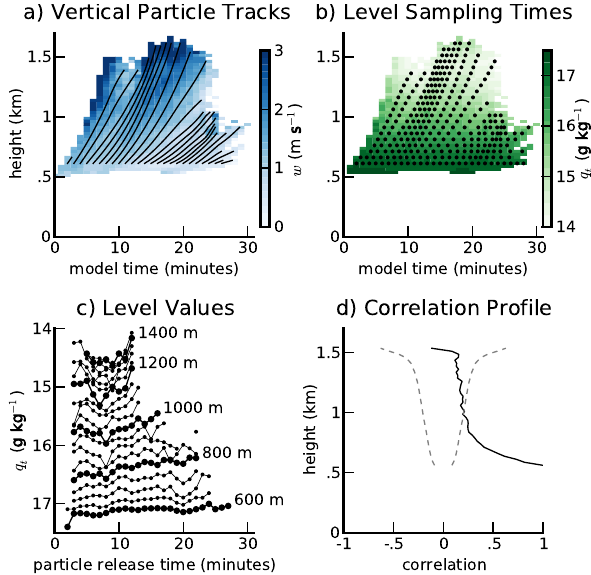
Fig. 10. Method used to determine correlations between lower- and upper-level cloud properties. (a) Numerical particles are released once per minute from an initial level in the cloud and advected ver- tically with the mean vertical velocity of the cloud until the particle leaves the cloud. (Lines show the time-height trajectories of the numerical particles and colours show the cloud’s vertical velocity.) (b) The times at which particles reach each model level are then identified and the cloud properties at those times are recorded. (Dots show the time each particle reaches each model level and colours show the cloud’s vertical velocity. Only half the model levels have been plotted for clarity.) (c) The properties encountered by the par- ticles at a given height are then arranged by the time each particle was released, forming a set of pseudo-time series at each height. (Dotted lines show the total specific water values of the cloud at the time each particle reached a given height. The 600m, 800m, 1000m, 1200m, and 1400m height particle values are highlighted and labeled. Only half the model levels have been plotted.) (d) Cor- relations are then taken between the properties of the particles at release and the properties at higher levels to calculate correlation profiles. (Solid line shows the correlation between total specific hu- midity of the particles at release and the total specific humidity of the cloud at various heights. Dotted lines show the 99% confidence level for a correlation to be significantly different than